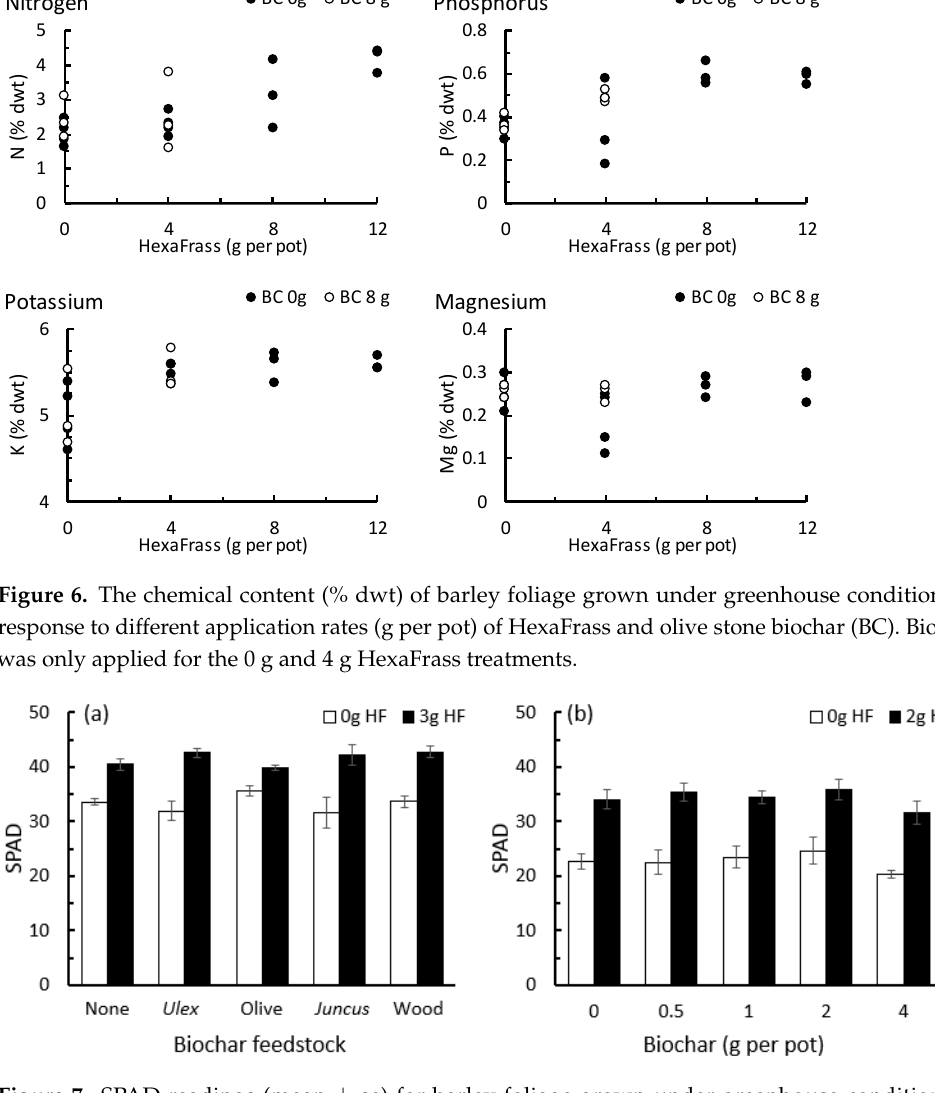
Figure 7. SPAD readings (mean ± se) for barley foliage grown under greenhouse conditions in response to application of HexaFrass (HF) and ( a ) biochar created from different feedstocks and ( b ) olive stone biochar applied at different rates (g per pot).